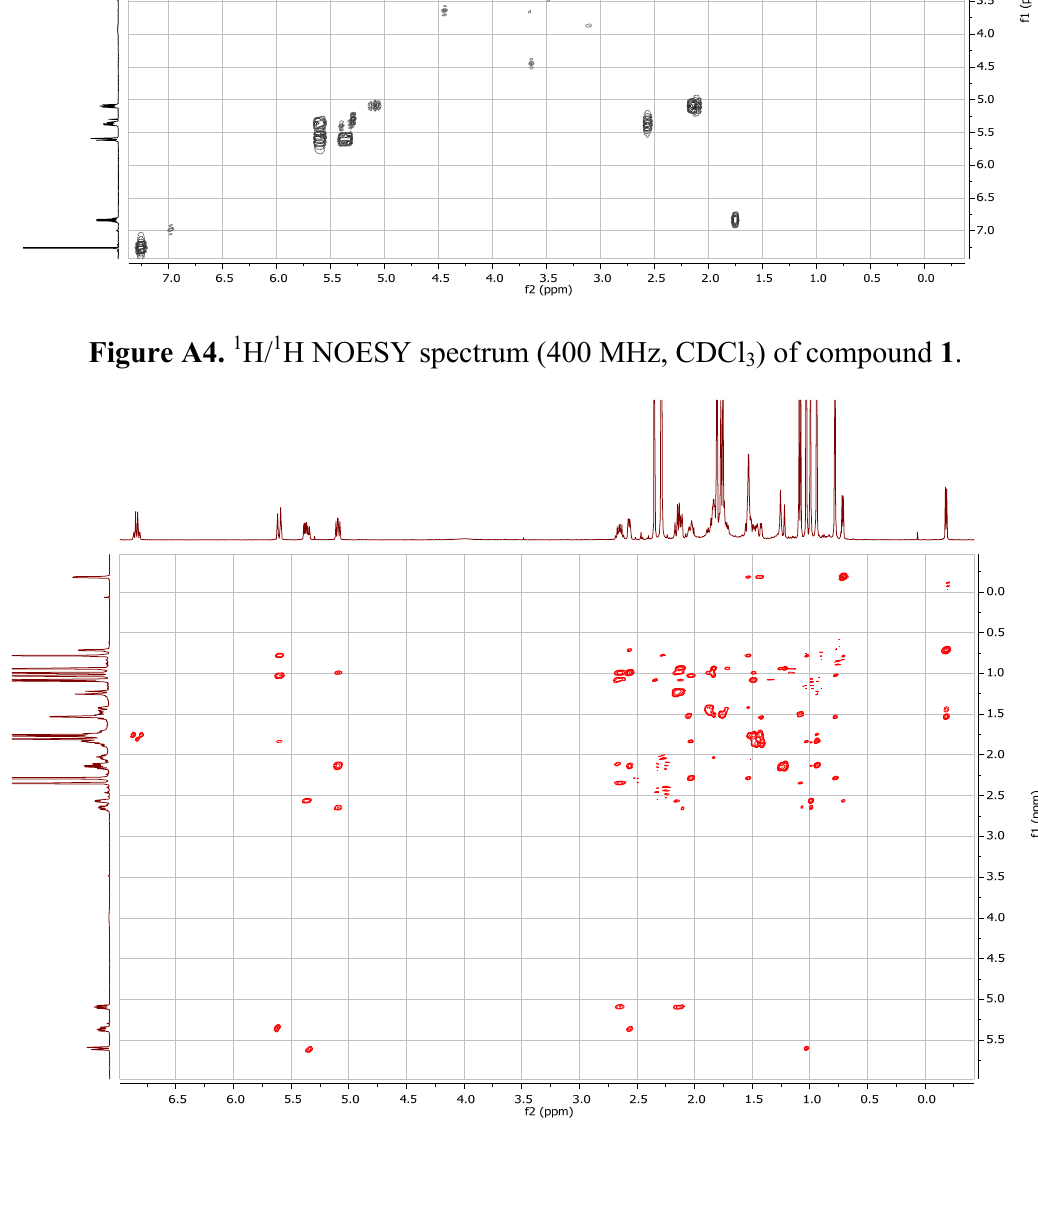
Figure A4. 1 H/ 1 H NOESY spectrum (400 MHz, CDCl